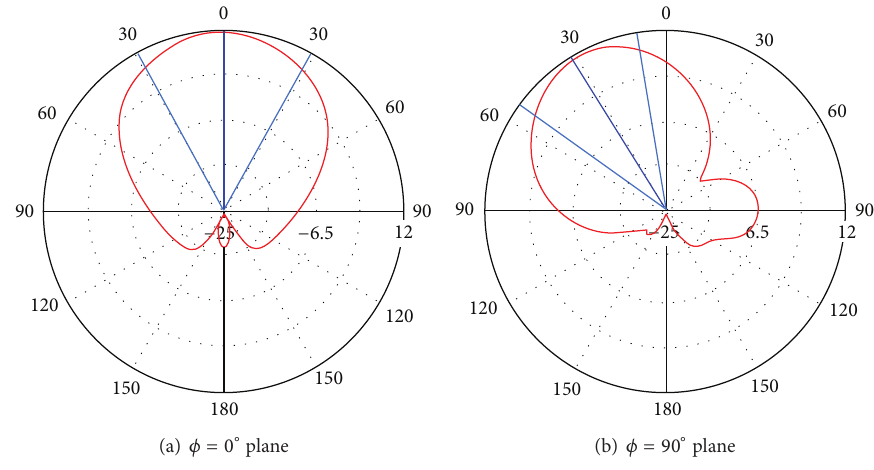
Figure 2: Gain patterns of bevel-cut design (using CST).